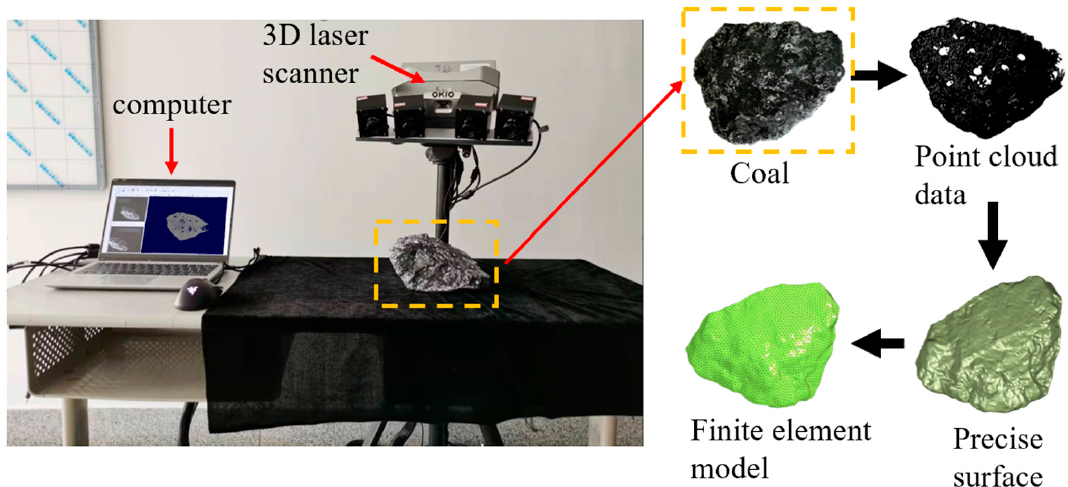
Figure 1. Construction process of finite element model of real shape coal block.